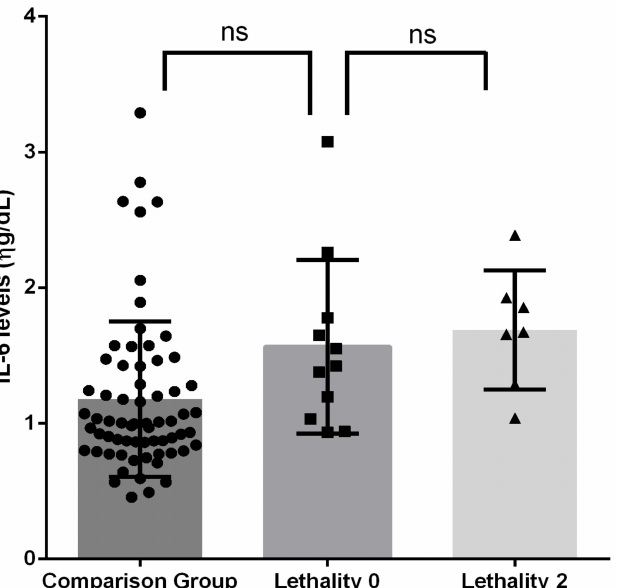
Figure 2. IL-6 levels in lethality of suicide attempts. ns: no statistical significance. The square triangle represents the comparison between